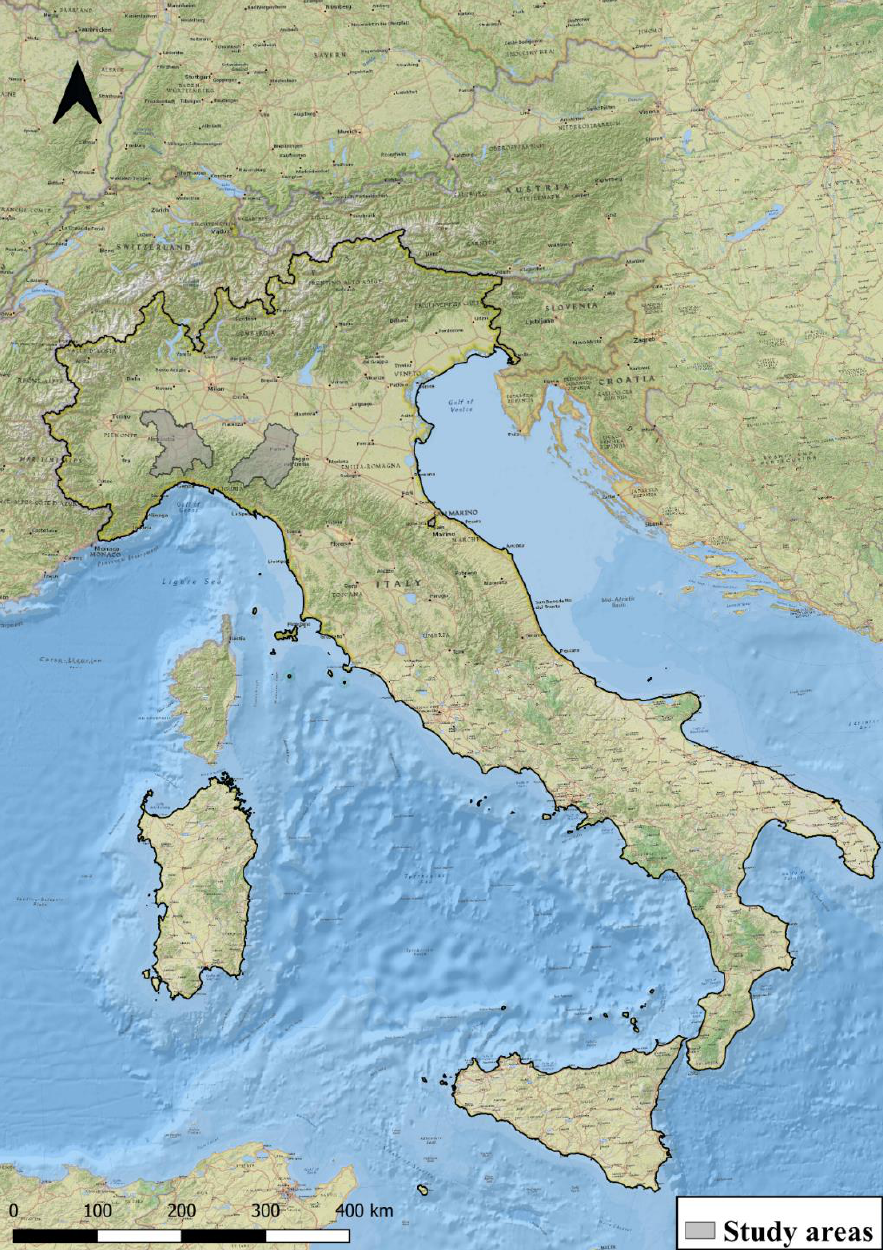
Figure 1. Location of the study areas in which the parasitological investigations were carried out (grey areas on the map): Alessandria province (grey area on the left) and Parma province (grey area on the right).